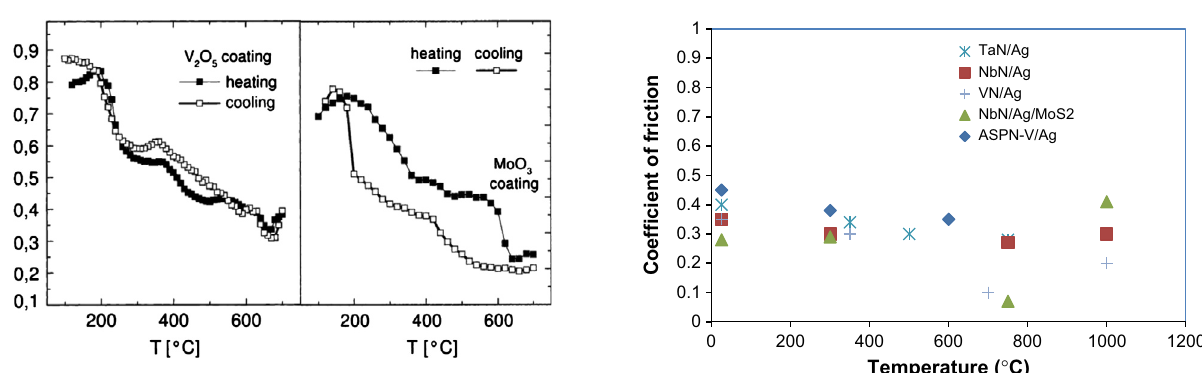
Figure 2. Temperature dependence of CoF for V 2 O 5 and MoO 3 on alumina substrates. An alumina ball ( U = 8 mm) on disc test with a load of 1 N was used to measure the CoF with a 10 (cid:2) C/min temperature sweep in the range of 100–700 (cid:2) C [30].